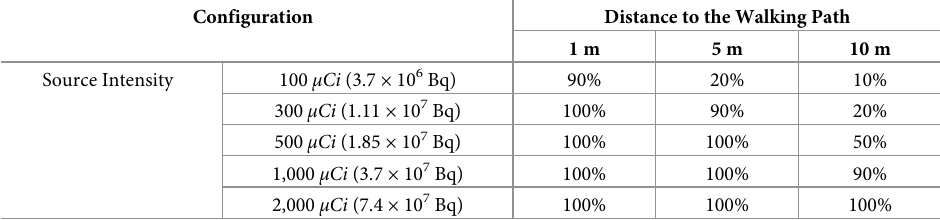
Table 5. Source identification accuracy with 20 meters distance